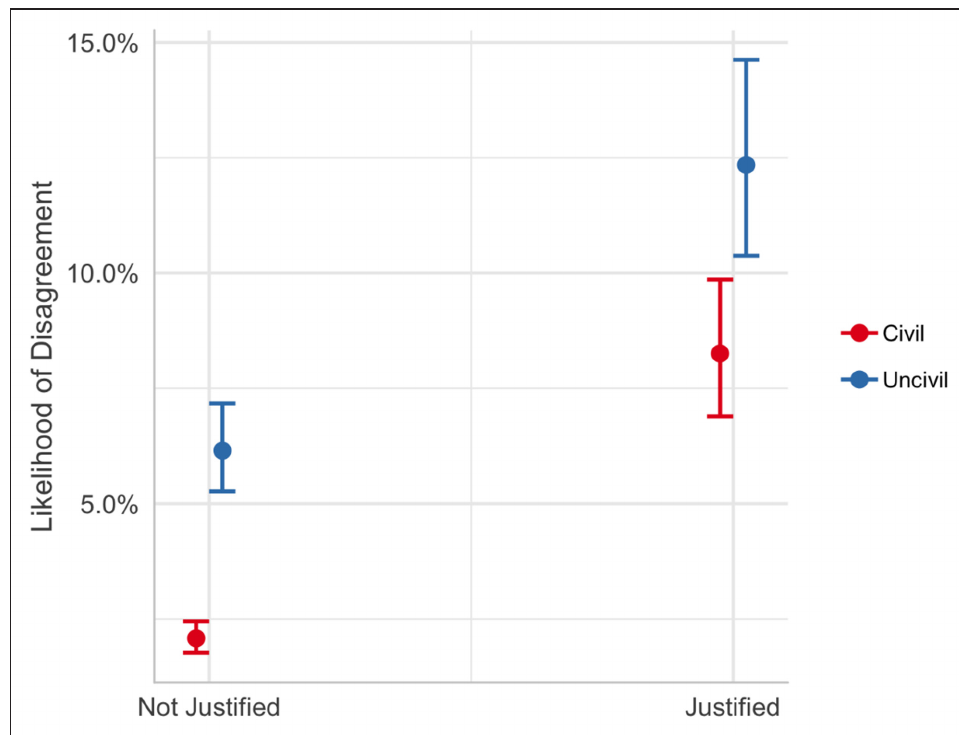
Figure 1: Predicted values for comments with disagreement based on justification and